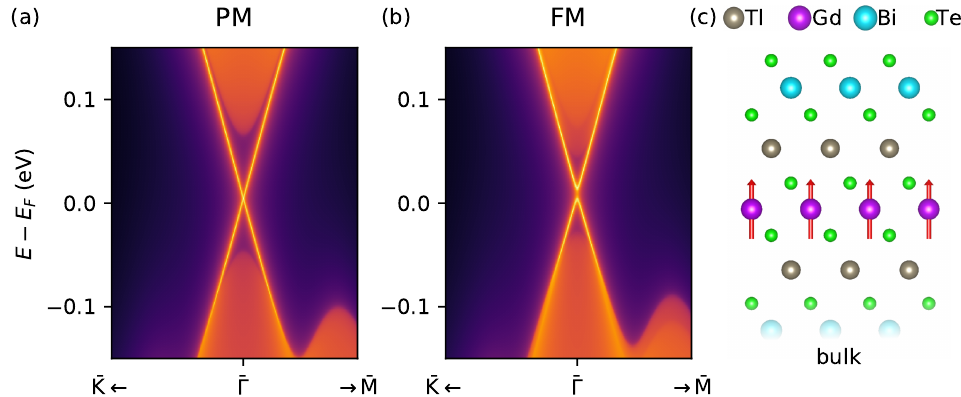
Figure 4. Surface electronic structure of TlGdTe 2 /(TlBiTe 2 ) 1 , calculated for the PM state ( a ) and FM state ( b ) for one the Te termination shown in ( c ). The regions with a continuous spectrum correspond to the bulk projected